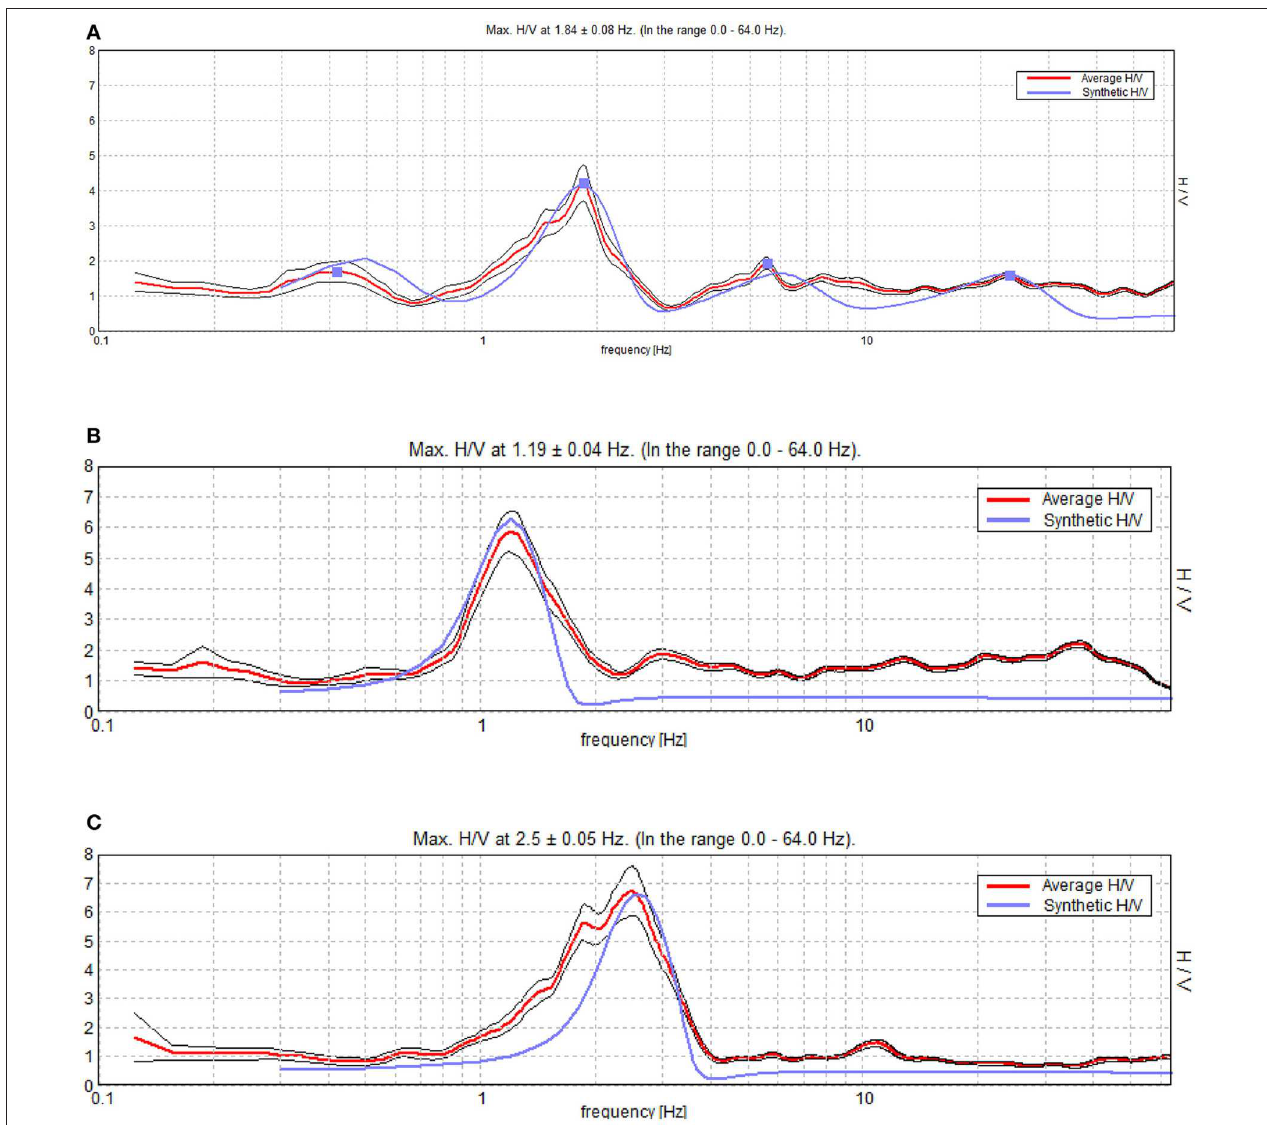
FIGURE 11 | H/V ratio measurements and derived spectrum from in situ shear wave velocity at various sites in Ecador. (A) Tarqui, Manta. (B) River Bank, Portoviejo. (C) Seismic measuring station APED, Pedernales.